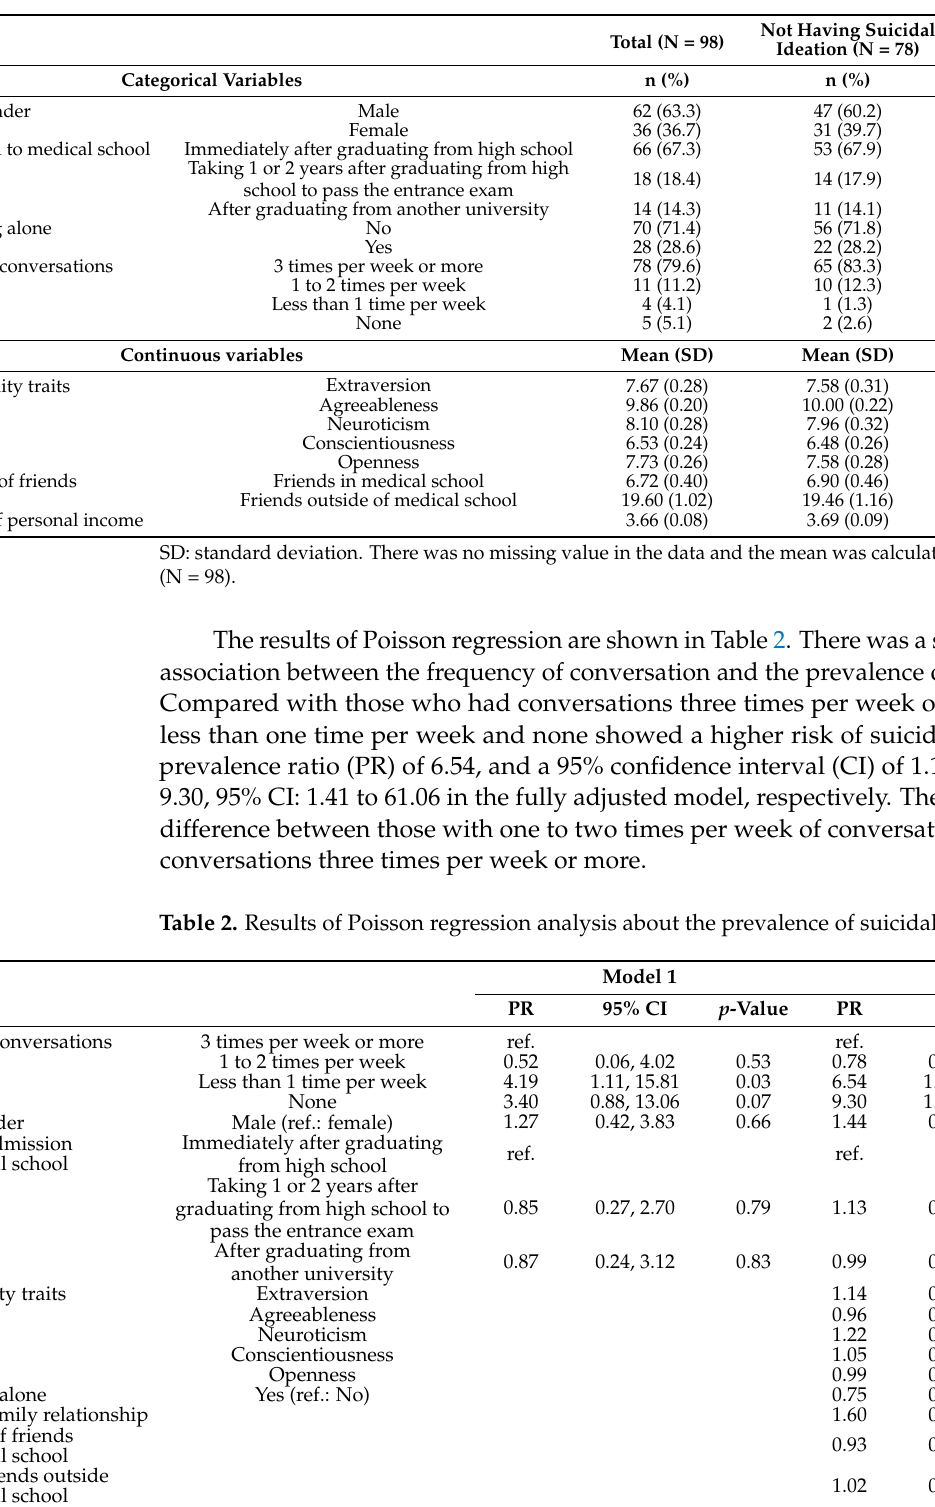
Table 1. Descriptive statistics of characteristics of students.